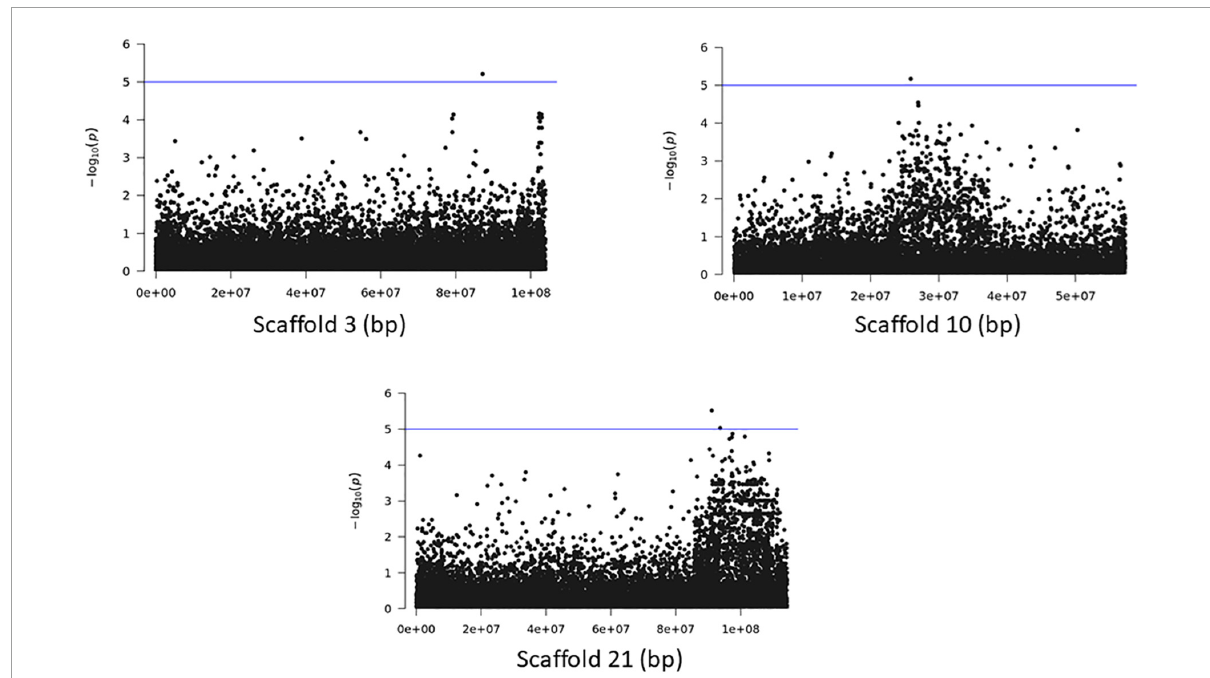
FIGURE12 Genome Wide Association analysis of the trait middle part of bamboo. Manhattan plots of scaffolds harboring INDELs with p ≤ 10 − 5